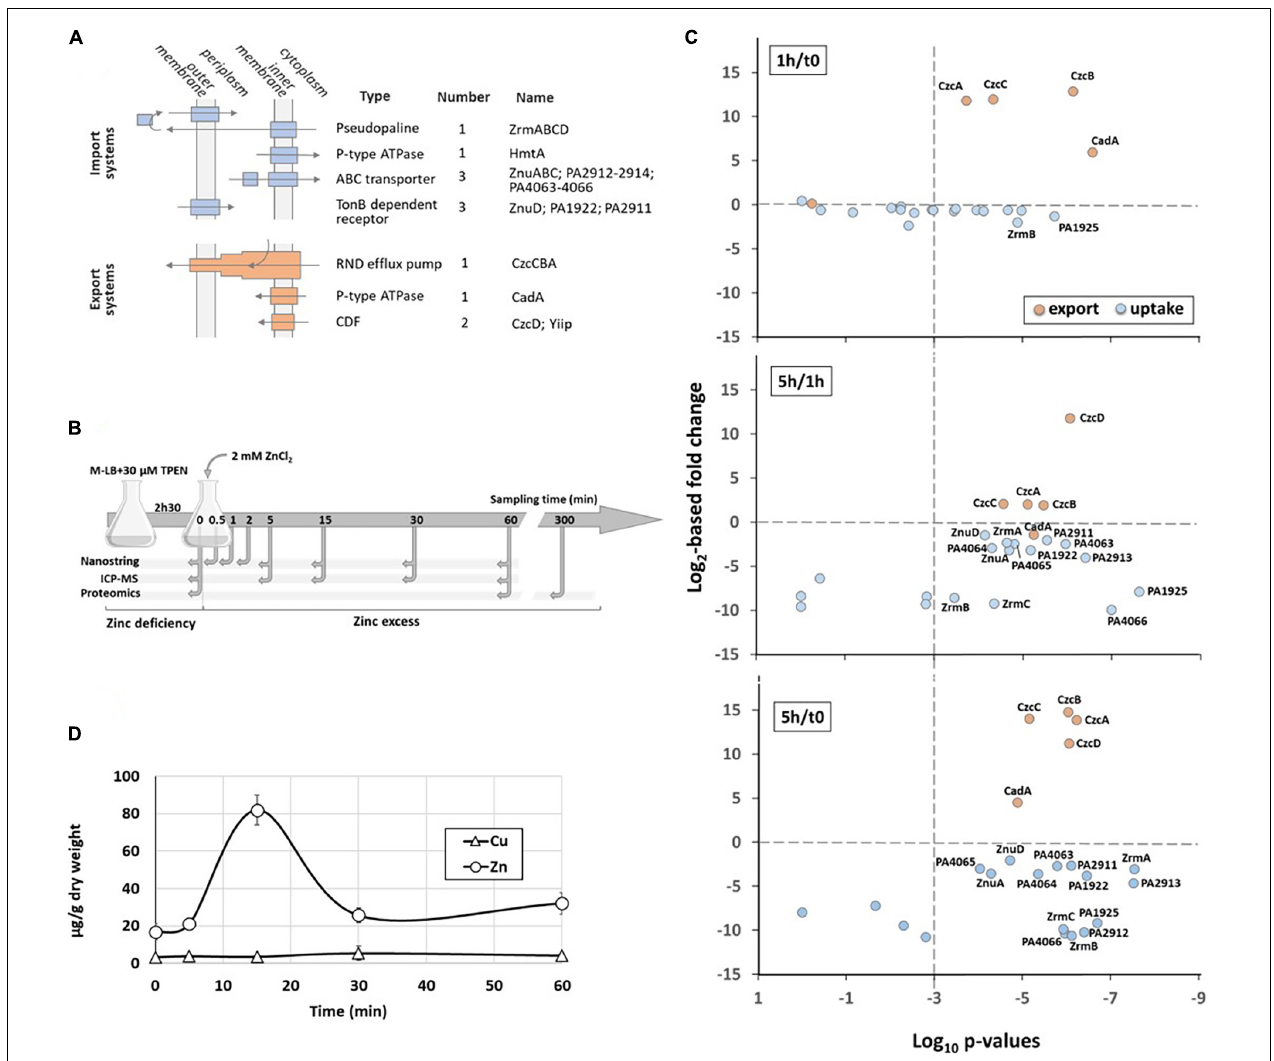
FIGURE 1 | Dynamics of Zn homeostasis in P. aeruginosa. (A) The four families of Zn import systems (in blue) and the 3 families of Zn export systems (in orange) are represented. Their cellular localization, the number of each representative and their name are indicated. (B) Schematic representation of the experimental setup and the times of sampling. (C) Relative abundance of the zinc transport systems. Graphs represent the correlation plots between the fold change (Log 2 value, y axis) after 1 h compared to t0 (upper panel), 5 h compared to 1 h (middle panel) or 5 h compared to t0 (lower panel) of Zn treatment, and their corresponding statistical values ( x axis). The p -values lower than 10 – 3 (to the right of the vertical dotted line) were considered as statistically significant. The average values obtained for t0 (or 1 h for the middle panel) correspond to 100%. (D) Changes in intracellular zinc concentration after addition of 2 mM ZnCl 2 to the medium. The metal concentrations in µ g/g cells (dry weight) were determined over time in the wild type strain by ICP-MS. The concentration of Cu, as control, is also plotted on the